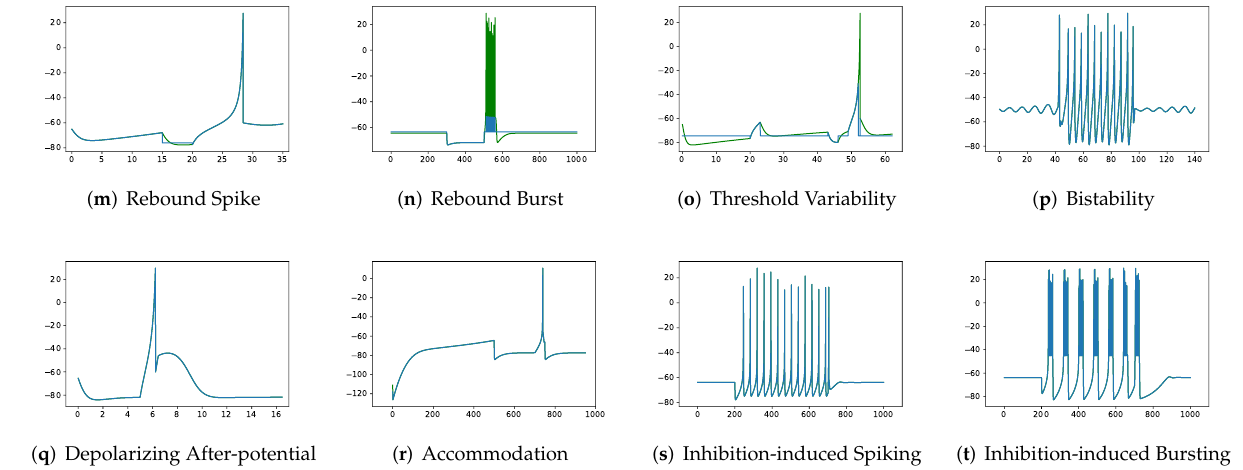
Figure 4. Membrane potentials of SSRM (blue) vs. Izhikevich Model (green), where y-axis is the membrane potential (mV) and x-axis is the time (ms).